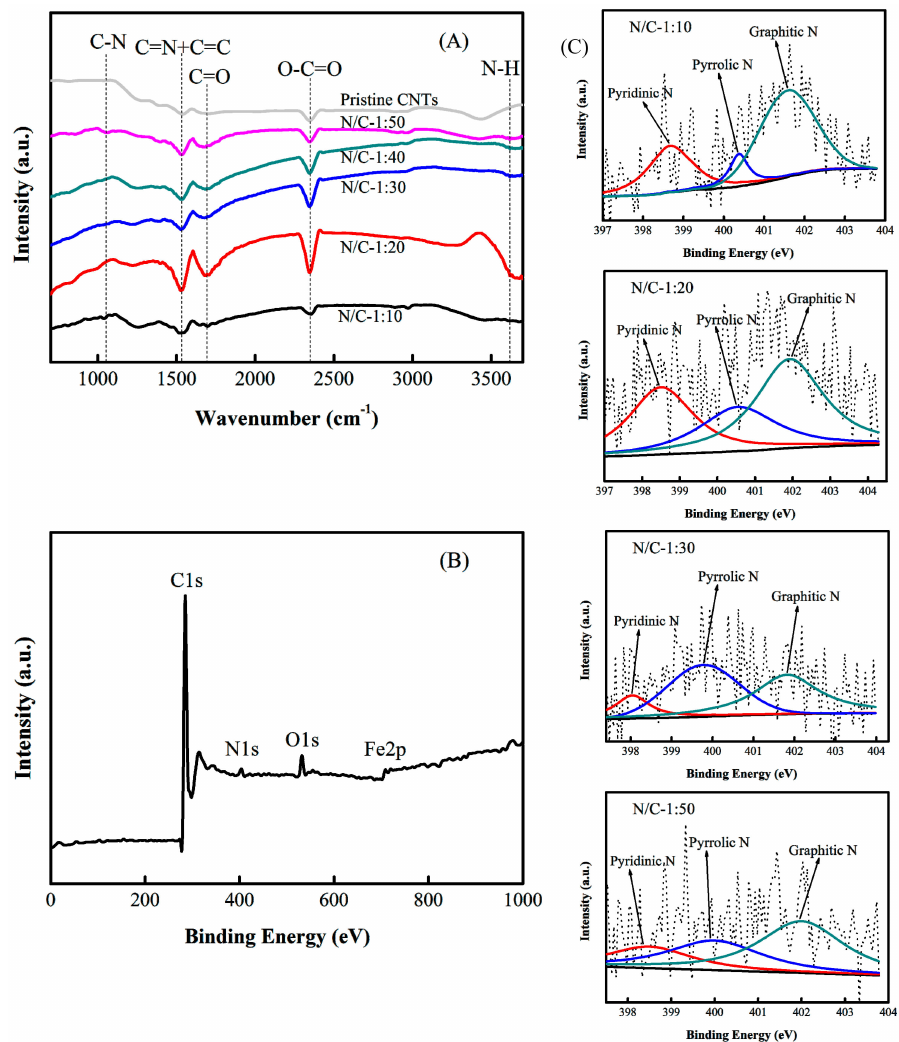
Figure 5. ( A ) Fourier transform infrared spectrometry (FTIR) spectra of the N-CNT arrays and pristine CNT arrays, ( B ) XPS spectra of a wide survey scan, and ( C ) high-resolution N1s XPS spectra of the N-CNT